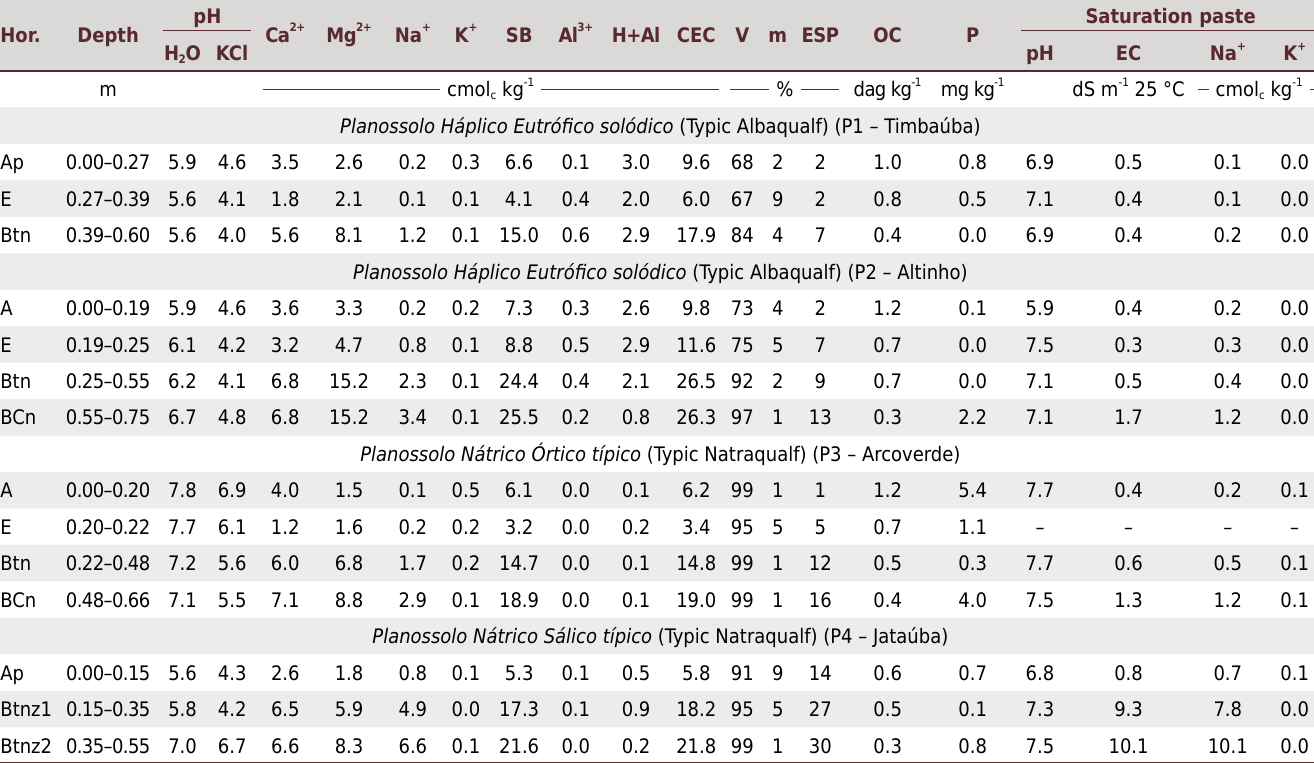
Table 3. Chemical analysis of four Planosols in different geo-environmental conditions in the State of Pernambuco